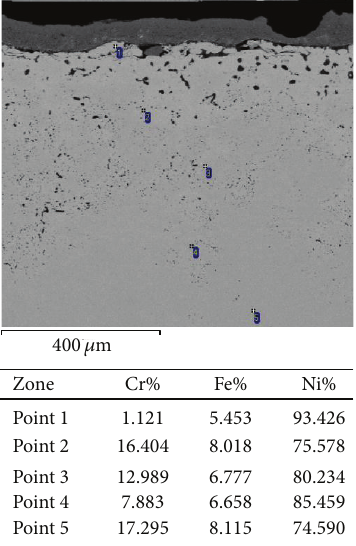
Figure 7: SEM image and EDS analysis of a cross-section of Inconel 600 after corrosion test at 900 ∘ C in NaCl-KCl